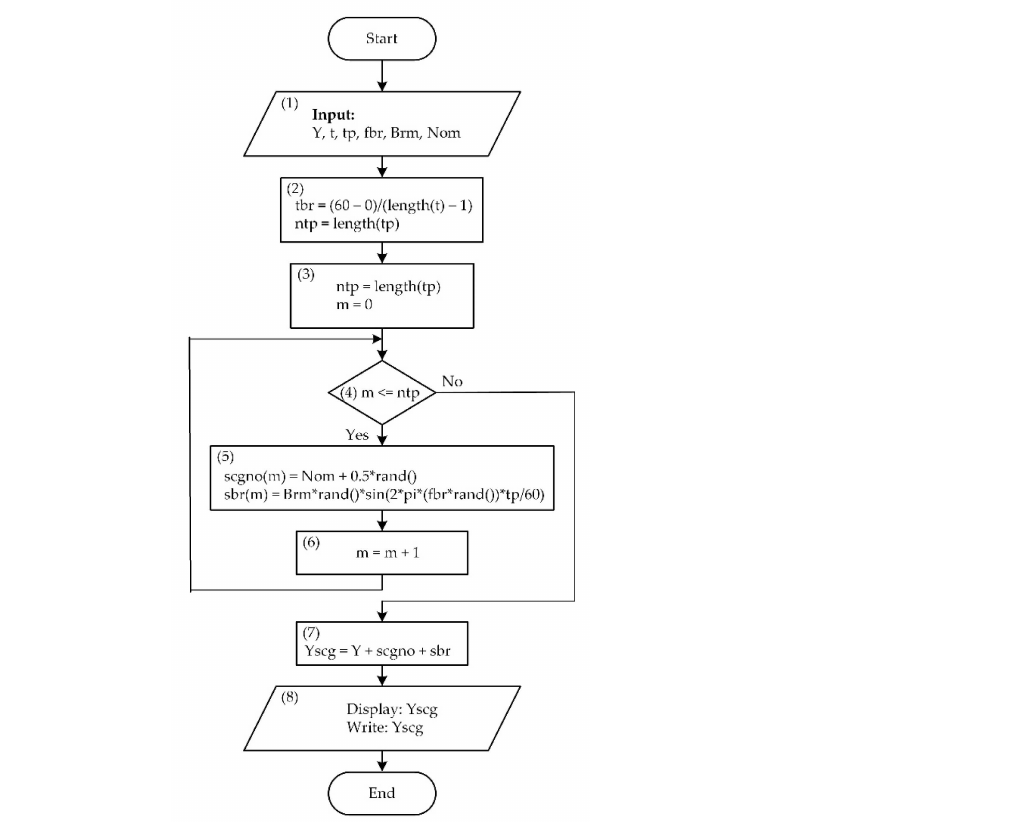
Figure 4. Adding breath noise and white noise signals to the modeled sequence of the seismocardio- gram signal